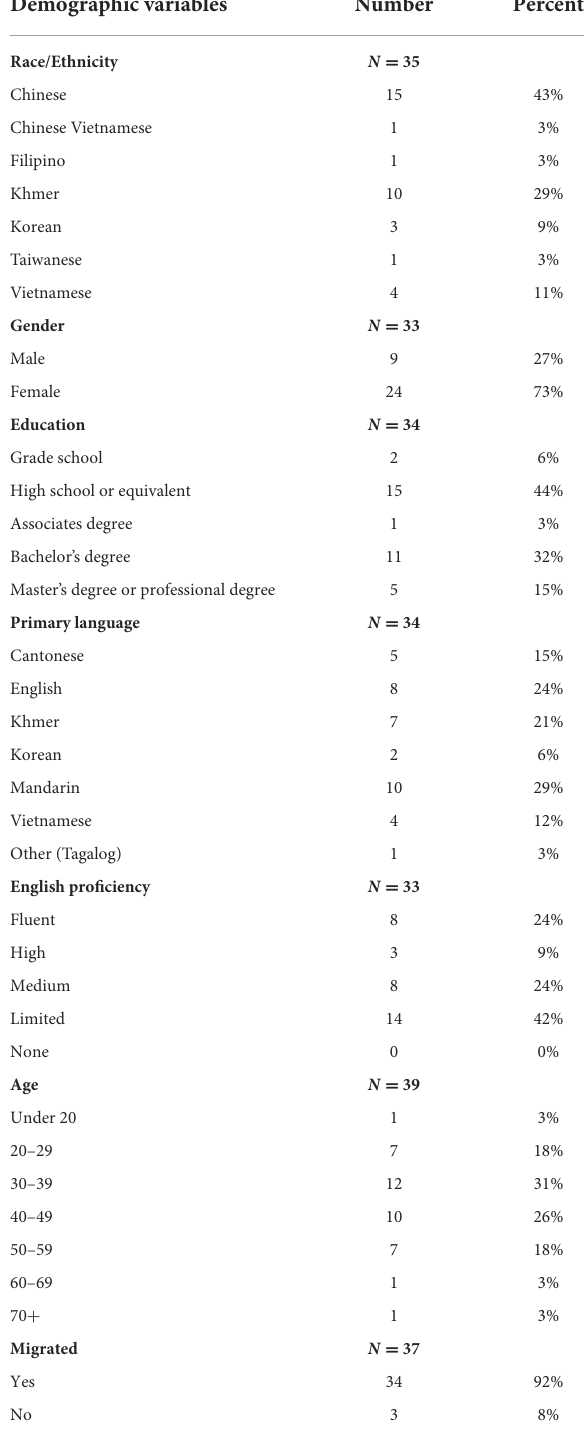
TABLE 1 Demographics information of the interview